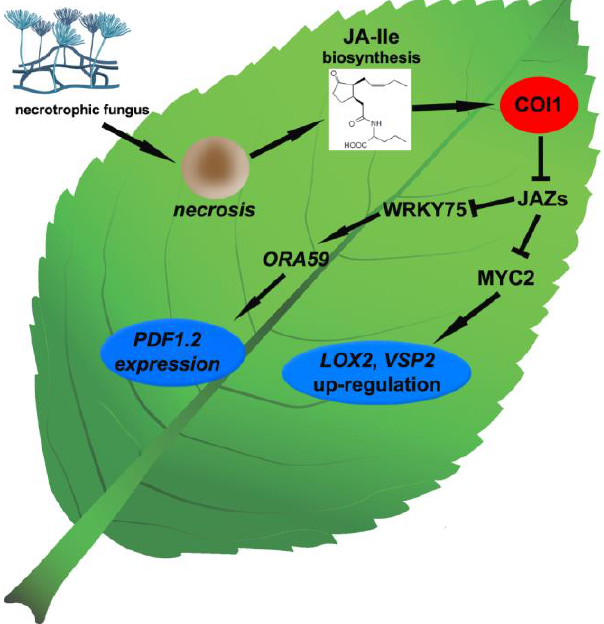
Figure 2. Infection of a plant within foliar tissues with a necrotrophic fungus triggers JA biosynthesis and JA perception via COI1 receptor complex regulated with JAZs and subsequent JA-dependent signal transduction through transcription factors such as WRKY75 and/or MYC2 and downstream expression of defense-related genes such as PDF1.2 , VSP2 and LOX2 . JA-responsive gene ORA59 was detected exclusively as being activated downstream WRKY75 [12,112,120]. Detailed description in the text.